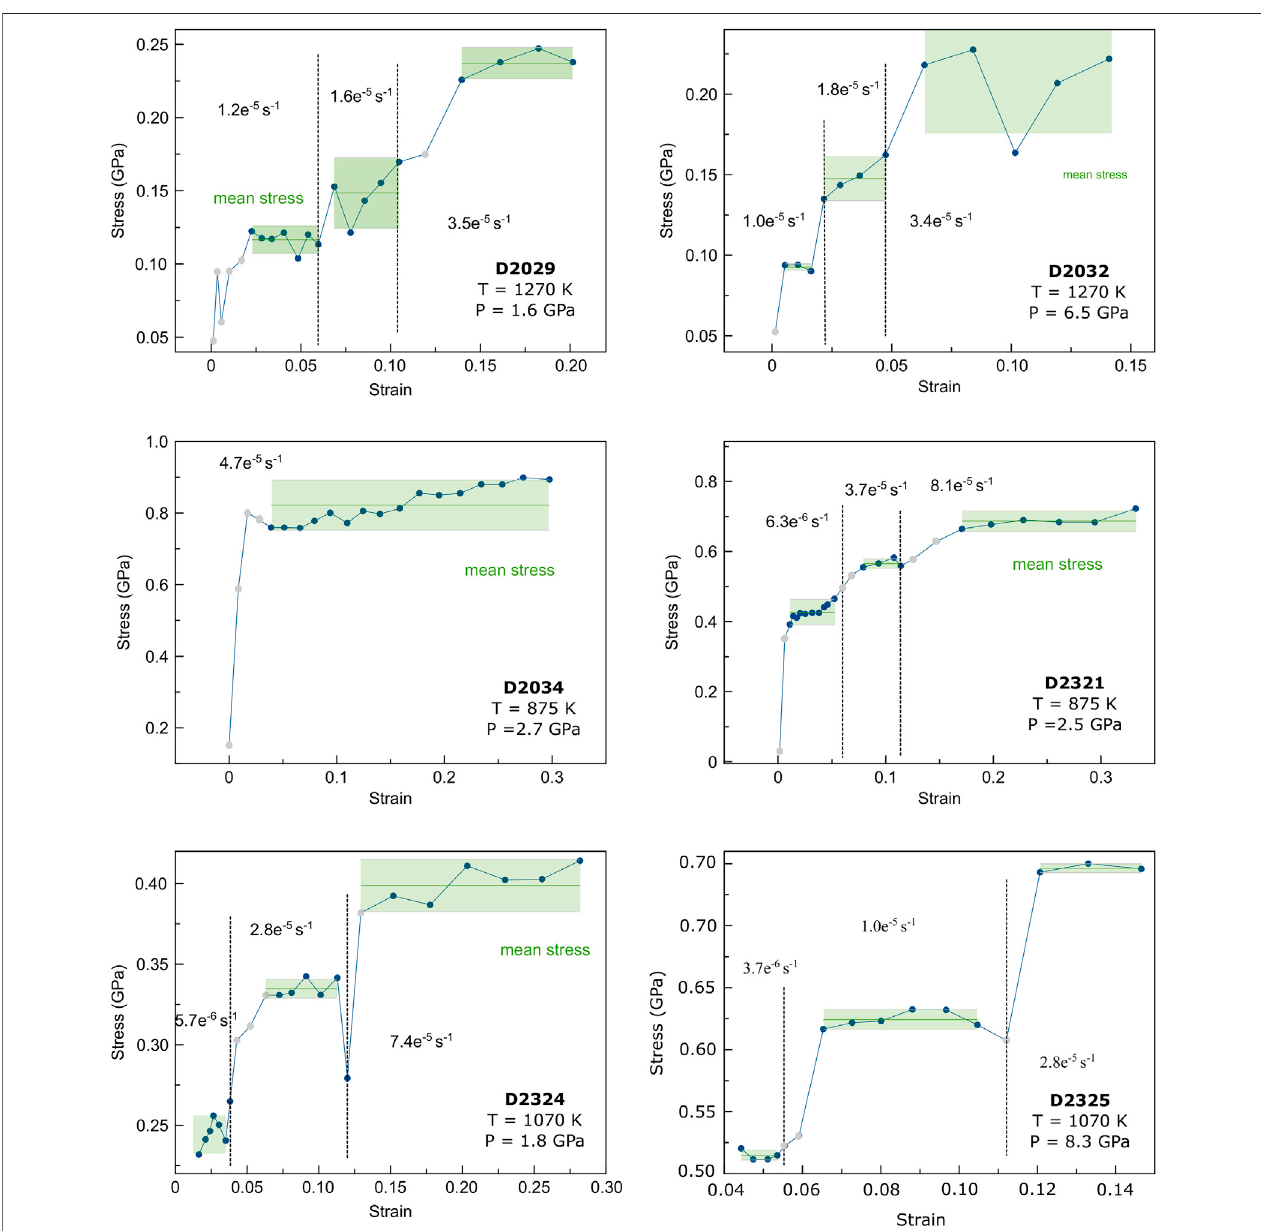
FIGURE3 | Stress vs. strain curvesfor all experiments. Grey data points indicate transient state before reaching steady state. Solid points are identi fi ed as “ steady state ” deformation and used for a computation of a mean stress (solid green line). Error bars in Table 1 were evaluated based on stress changes during steady-state, indicated by the green